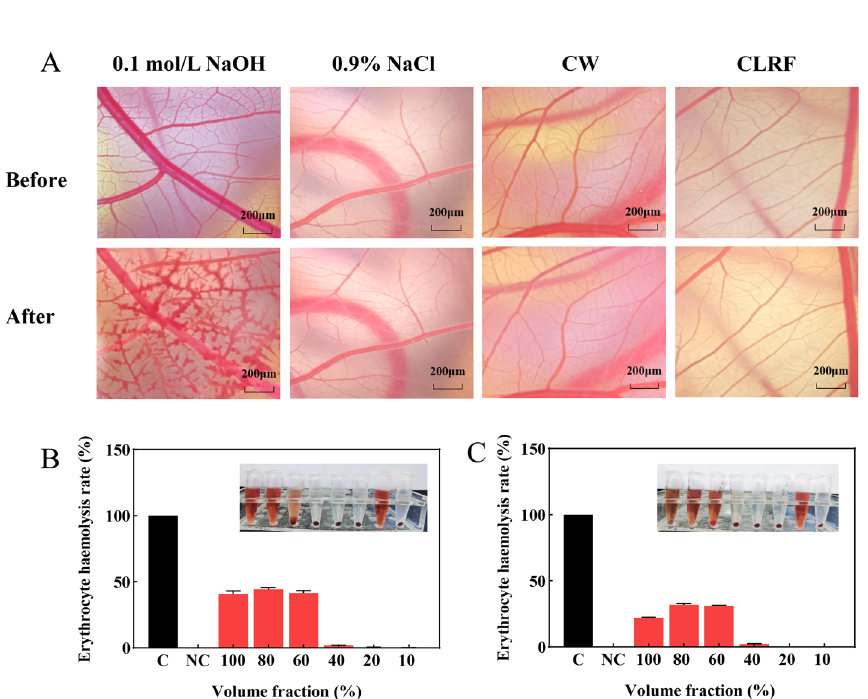
Figure 2. Safety measurements of CW and CLRF: ( A ) Vascular presentation and response plots before and after representative CAM spiking for CW and CLRF; ( B ) Erythrocyte hemolysis rates for different volume fractions of CW; ( C ) Erythrocyte hemolysis rates for different volume fractions of CLRF. In the photographs in Figure 2B and C, the red colour of the solution in the centrifuge tube correlates positively with erythrocyte haemolysis. The supernatant of the centrifuge tube is colourless and clear with a red precipitate at the bottom, indicating low or no haemolysis of the sample. CW: Coix seed water extract; CLRF: Coix seed Lactobacillus reuteri fermentation broth. Each value is expressed as mean ± SD ( n = 3). Table 4. Results of Eye Irritation of Chicken Chorioallantoic Membrane.